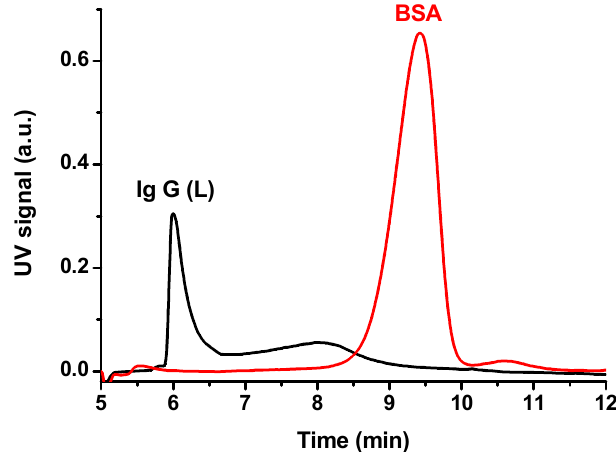
Figure 6. Asymmetrical flow field-flow fractionation of the fraction 10–30 kDa obtained after centrifugation of a monoclonal antibody preparation (clone 2H3C6; black curve), and BSA as a reference protein (red curve). The fraction was additionally concentrated 20 times by centrifugation through 3 kDa filters.